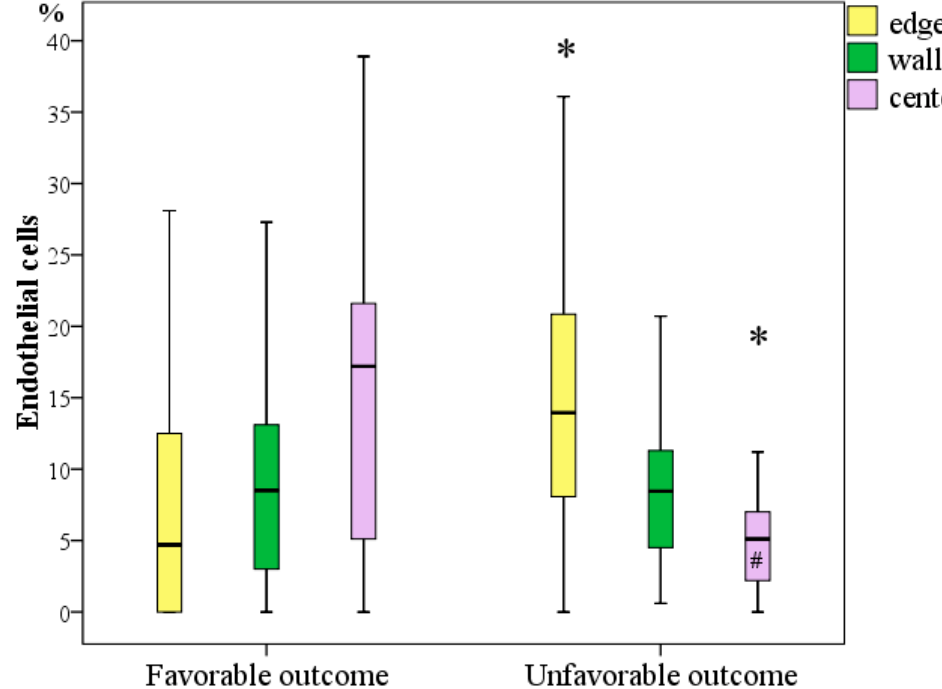
Figure 7. Frequency of occurrence of endotheliocytes in chronic diabetic foot wounds with different outcomes on Day 1 during primary surgical treatment (*—difference between groups in terms of outcome at p < 0.05, Mann–Whitney U test; #—a significant increase in the number of cells relative to their content in the centre of the wounds within one outcome subgroup at p < 0.05, Friedman test). Correlation analysis showed the presence of significant relationships between ad- verse outcomes and the concentration of endotheliocytes in the wound margin (r =